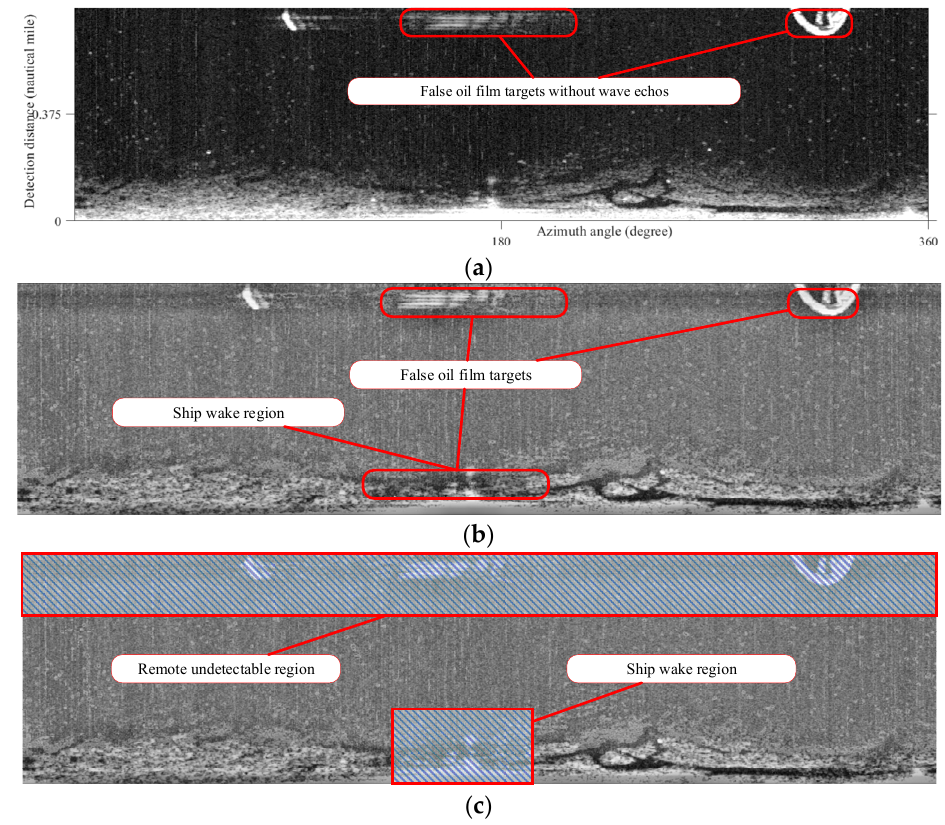
Figure 14. Oil spill misidenti fi cation conditions. ( a ) Misidenti fi cations were generated in long detec- tion range without no wave echo information in the noise reduction image; ( b ) Misidenti fi cations were generated in ship wake region in the contrast enhanced image; ( c ) The oil spill remote undetectable region and the ship wake misjudgment region were established.